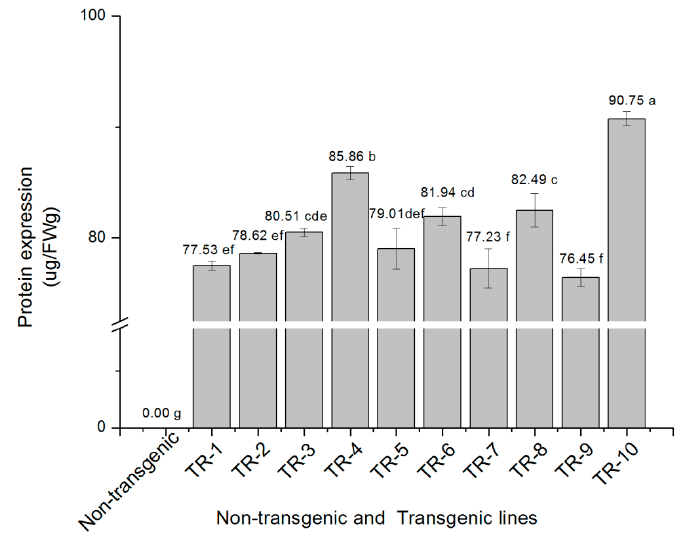
Figure 5. The cry2A protein expression in the leaves of non- transgenic and 10 different transgenic sugarcane lines detected by quantitative ELISA. The value is the average of three replicate experiments ± standard deviation ( n = 3), and the different letters indicate significant difference at 0.05 level.